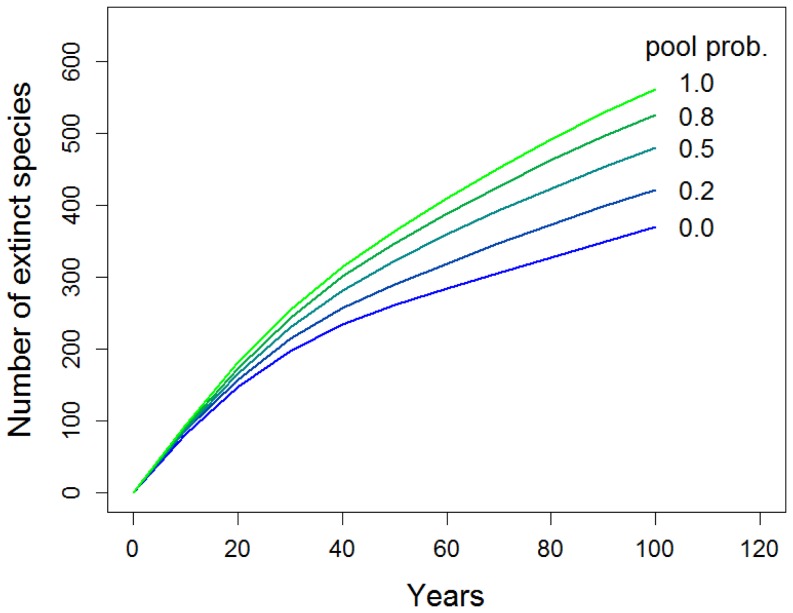
Number of extinct species predicted by the population viability analyses (PVAs) of 1618 vascular plant taxa in Japan.Results correspond to different scenarios in the choice of a rate of change class for the PVAs: classes were drawn (i) only from a pool of observed classes for each taxon in all of Japan (pool P = 1.0); (ii) from both the pool and the classes observed in the same cell at a certain ratio (P = 0.2–0.8); and (iii) only from those observed in the same cell (P = 0.0). Results from assumption (i) always gave the greatest rate of extinction.